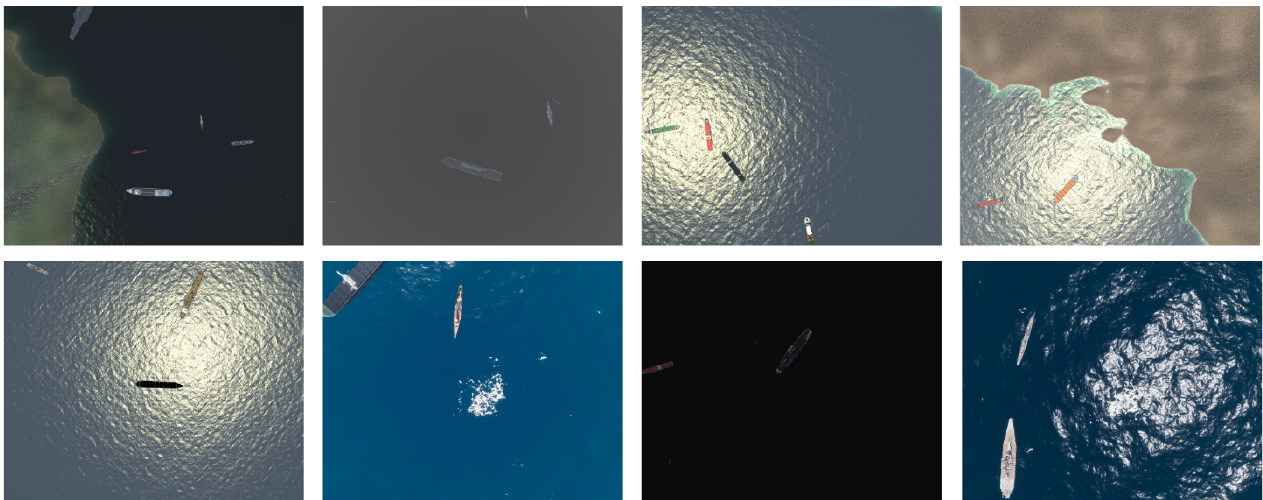
Figure 10. Examples from the UnityShip synthetic dataset.